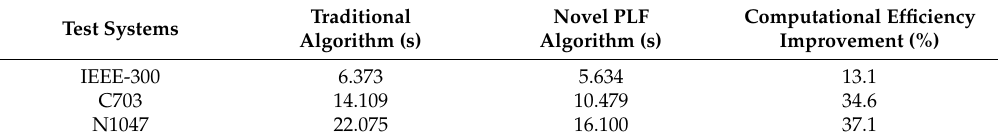
Table 1. Computational efficiency of traditional and novel probabilistic load flow (PLF)